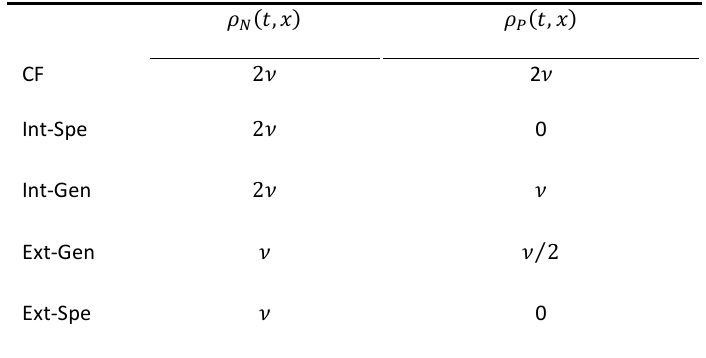
Table 3 - Effects of pest management practices on the pest and the natural enemies in conventional (CF) and organic farming. Four organic farming systems were considered. Int-Spe and Int-Gen correspond to intensive pest management (high pest mortality) while Ext-Spe and Ext-Gen are less intensive. In Int-Spe and Ext-Spe systems, pest management practices are specific to the pest and do not affect predators while in Int-Gen and Ext-Gen systems, management is less